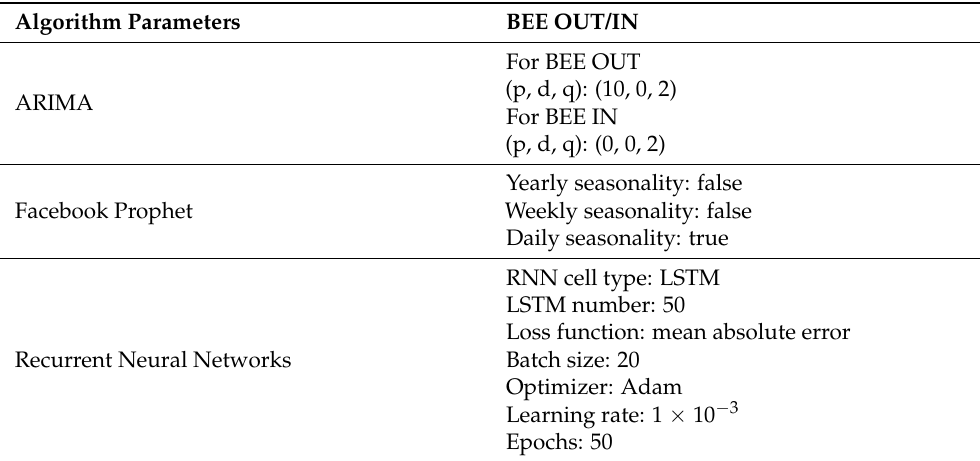
Table 4. Comparison of summarized optimal parameters for all investigated methods. Algorithm